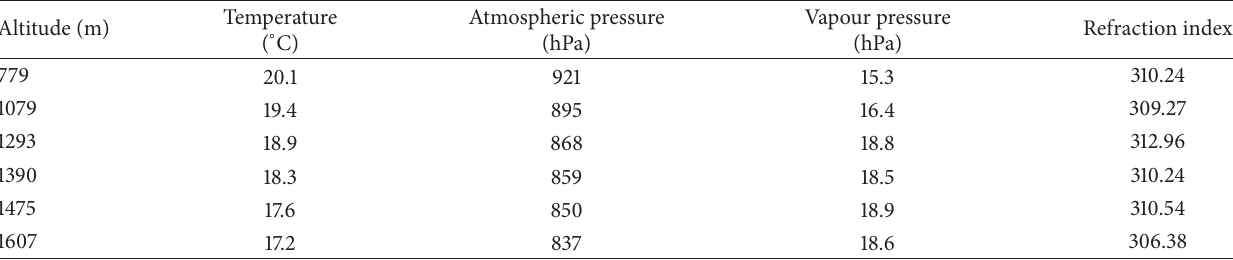
Table 4: Sounding data at 8:00 on July 6, 2014, for the Taiyuan